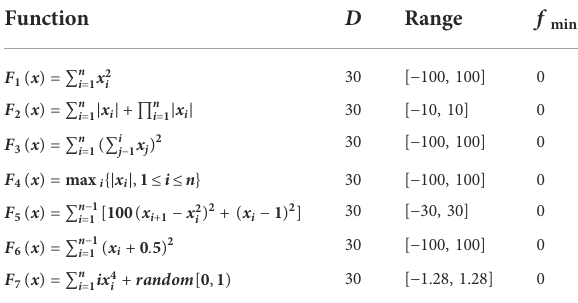
TABLE 2 Unimodal benchmark